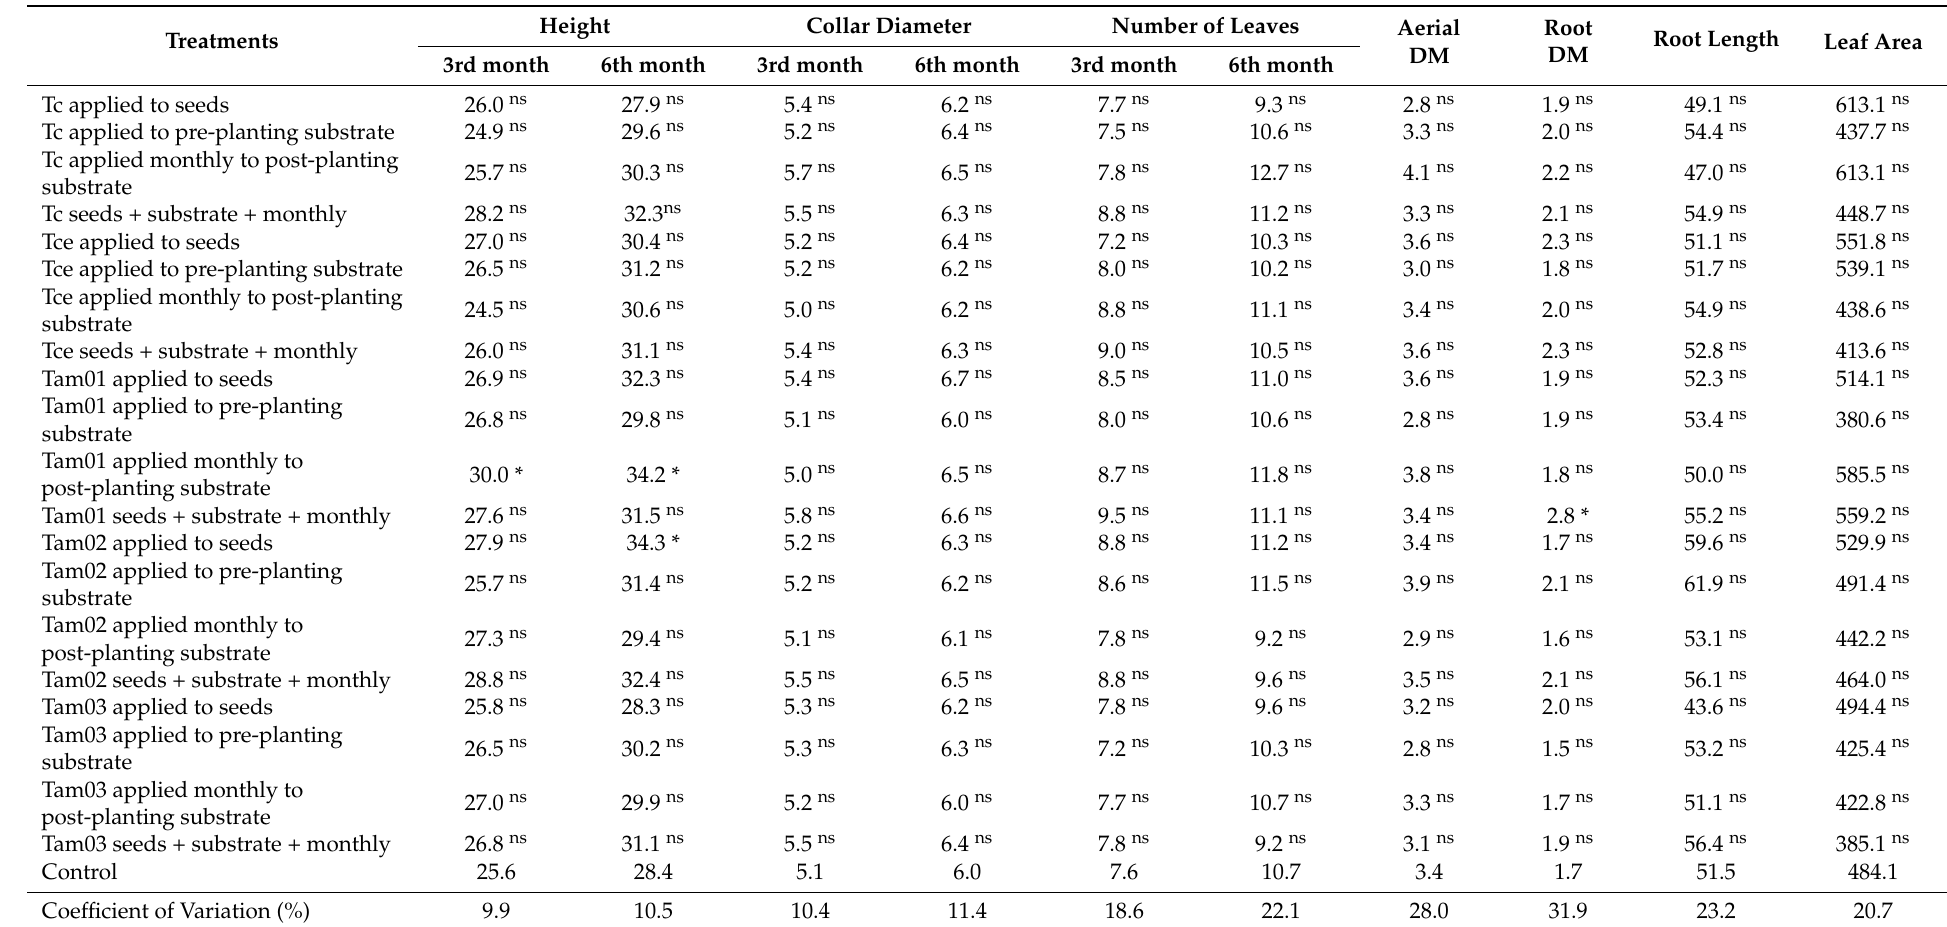
Table 2. Height (cm), diameter of the collar (mm), number of leaves per plant, dry mass (DM) of aerial shoot and root system (g), root length (cm), and leaf area (cm 2 ) of Theobroma cacao seedlings submitted to different application modes and Trichoderma spp.